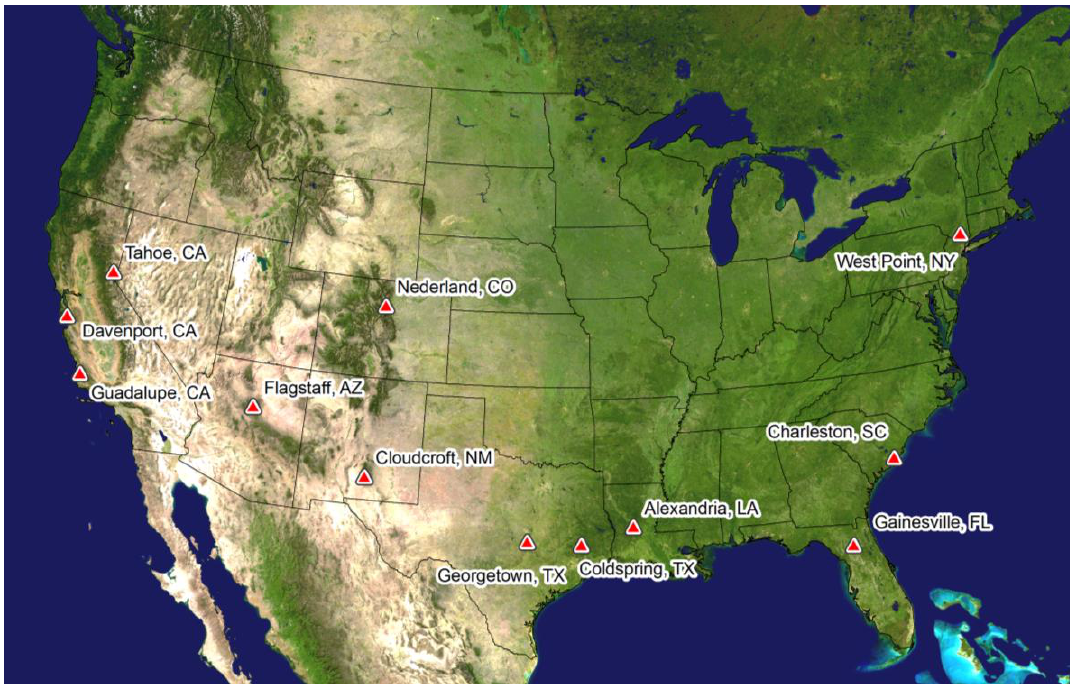
Figure 1. A map showing all the forest study sites used in this research. Table 1. Forest study sites and description.